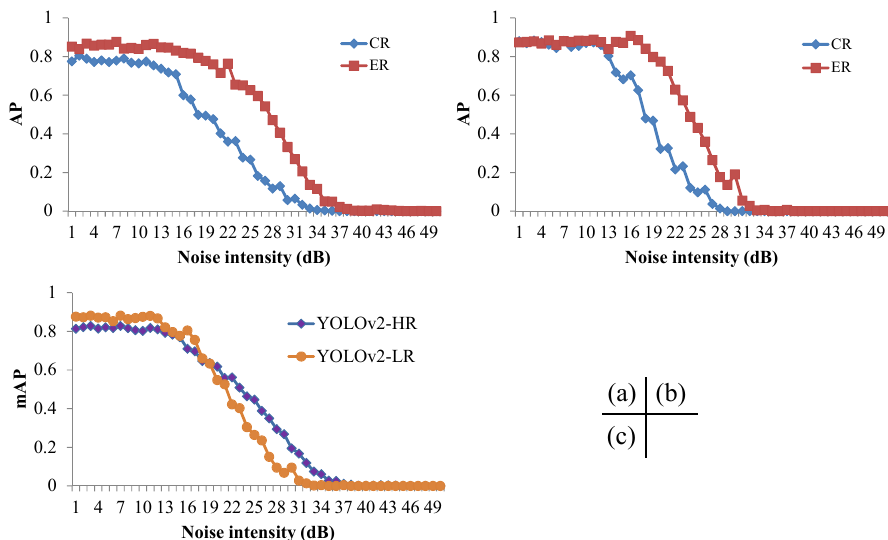
Figure 12. The detection results of the YOLOv2 in the influence of noise: ( a ) using high-resolution feature image; ( b ) using low-resolution feature image; ( c ) the mAP of the YOLOv2-HR and YOLOv2-LR.